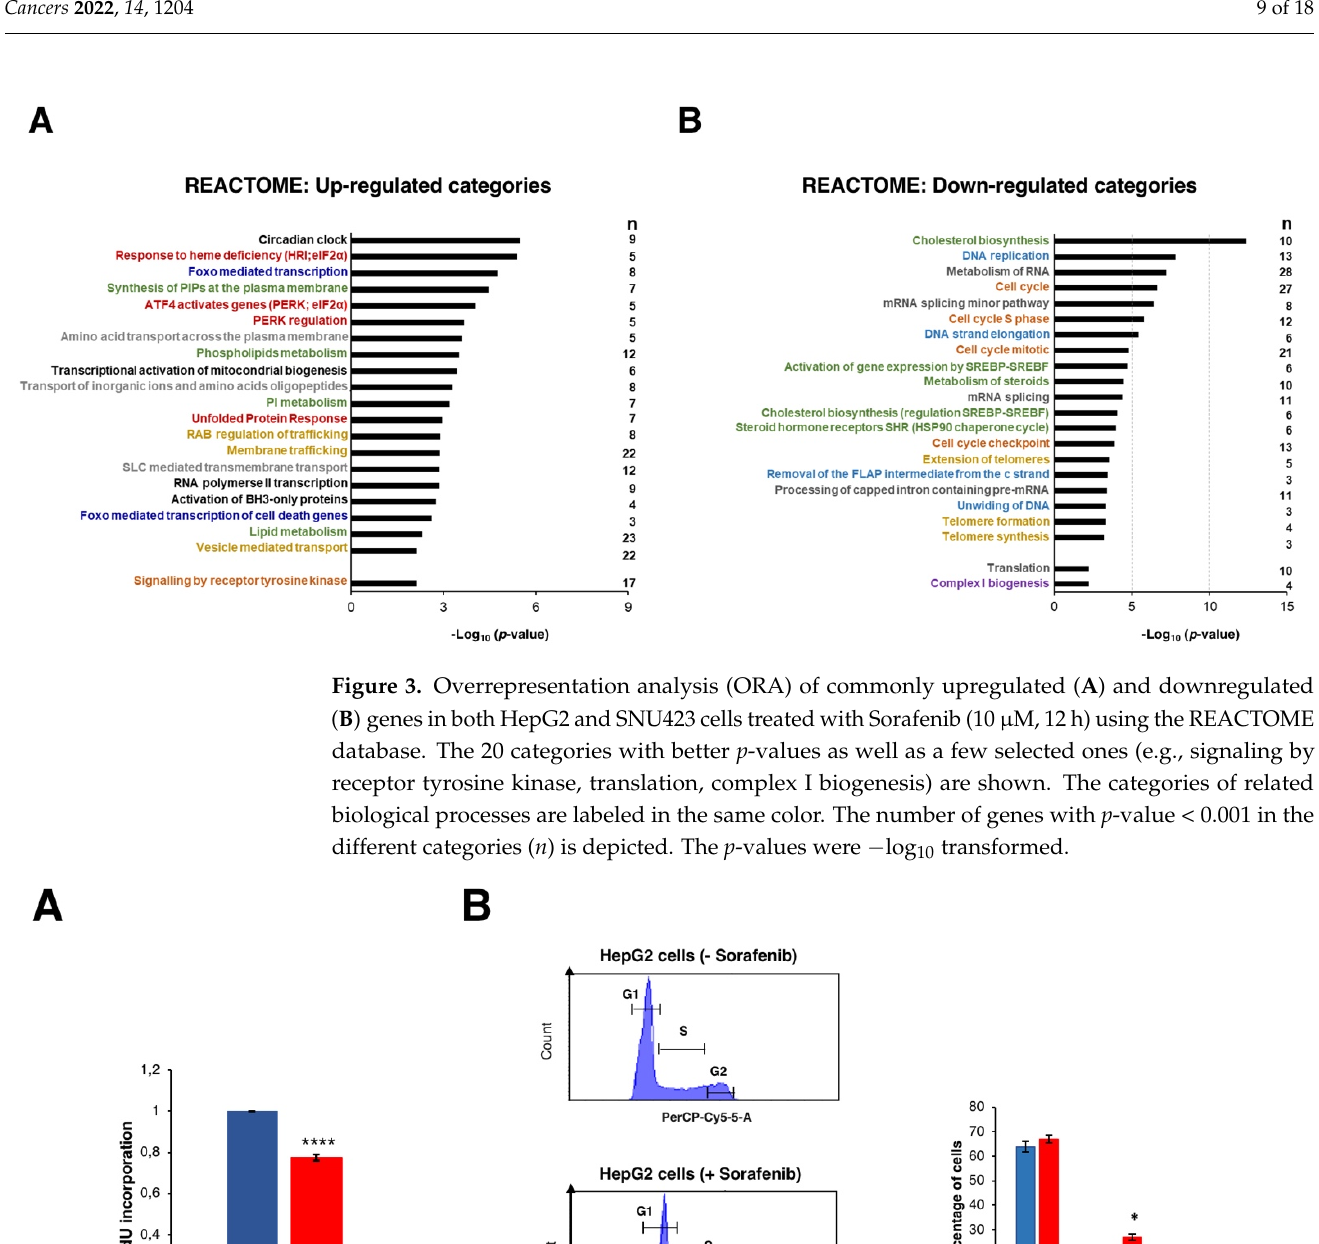
Figure 4. Effects of Sorafenib on cell proliferation and cell cycle. ( A ) BrdU incorporation assay on HepG2 cells treated or not with 10 µM Sorafenib. Results are expressed as the mean ± S.D. of three